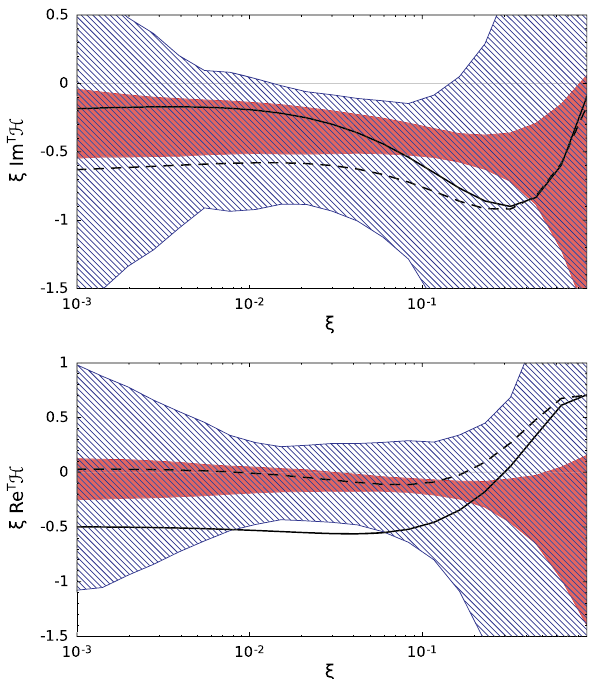
Fig. 2 Imaginary (up) and real (down) part of TCS CFF ξ T H (ξ) for Q 2 = 2 GeV 2 and t = − 0 . 3 GeV 2 as a function of ξ . The shaded red (dashed blue) bands correspond to the data-driven predictions com- ing from the global fit of DVCS data presented in [16] and they are evaluated using LO (NLO) spacelike-to-timelike relations. The bends show 68% confidence level for the uncertainties of presented quanti- ties. The dashed (solid) lines correspond to the GK GPD model [34–36] evaluated with LO (NLO) TCS coefficient functions